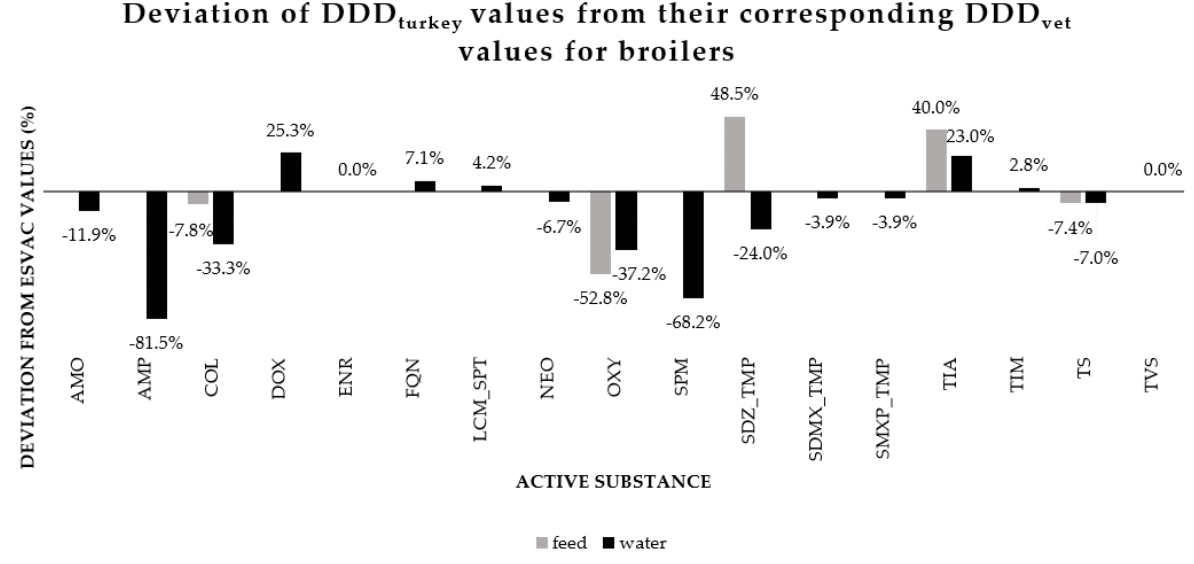
Figure 1. Deviation of DDD turkey values from their corresponding DDD vet values, stratified by unique combinations of active substance and administration route. DDD vet values are set to 0%. A plus sign before the percentage means that the DDD turkey value was higher than its corresponding DDD vet value. A minus sign means that the DDD turkey value was lower. All 0% deviations belong to active substances administered via water. AMO = amoxicillin; AMP = ampicillin; COL = colistin; DOX = doxycycline; ENR = enrofloxacin; FQN = flumequin; LCM_SPT = lincomycin in combination with spectinomycin; NEO = neomycin; OXY = oxytetracycline; SPM = spyramycin; SDZ_TMP = sulfadiazine in combination with trimethoprim; SDMX_TMP = sulfadimethoxine in combination with trimethoprim; SMXP_TMP = sulfamethoxypyridazine in combination with trimethoprim; TIA = tiamuline; TIM = tilmicosin; TS = tylosin; TVS =